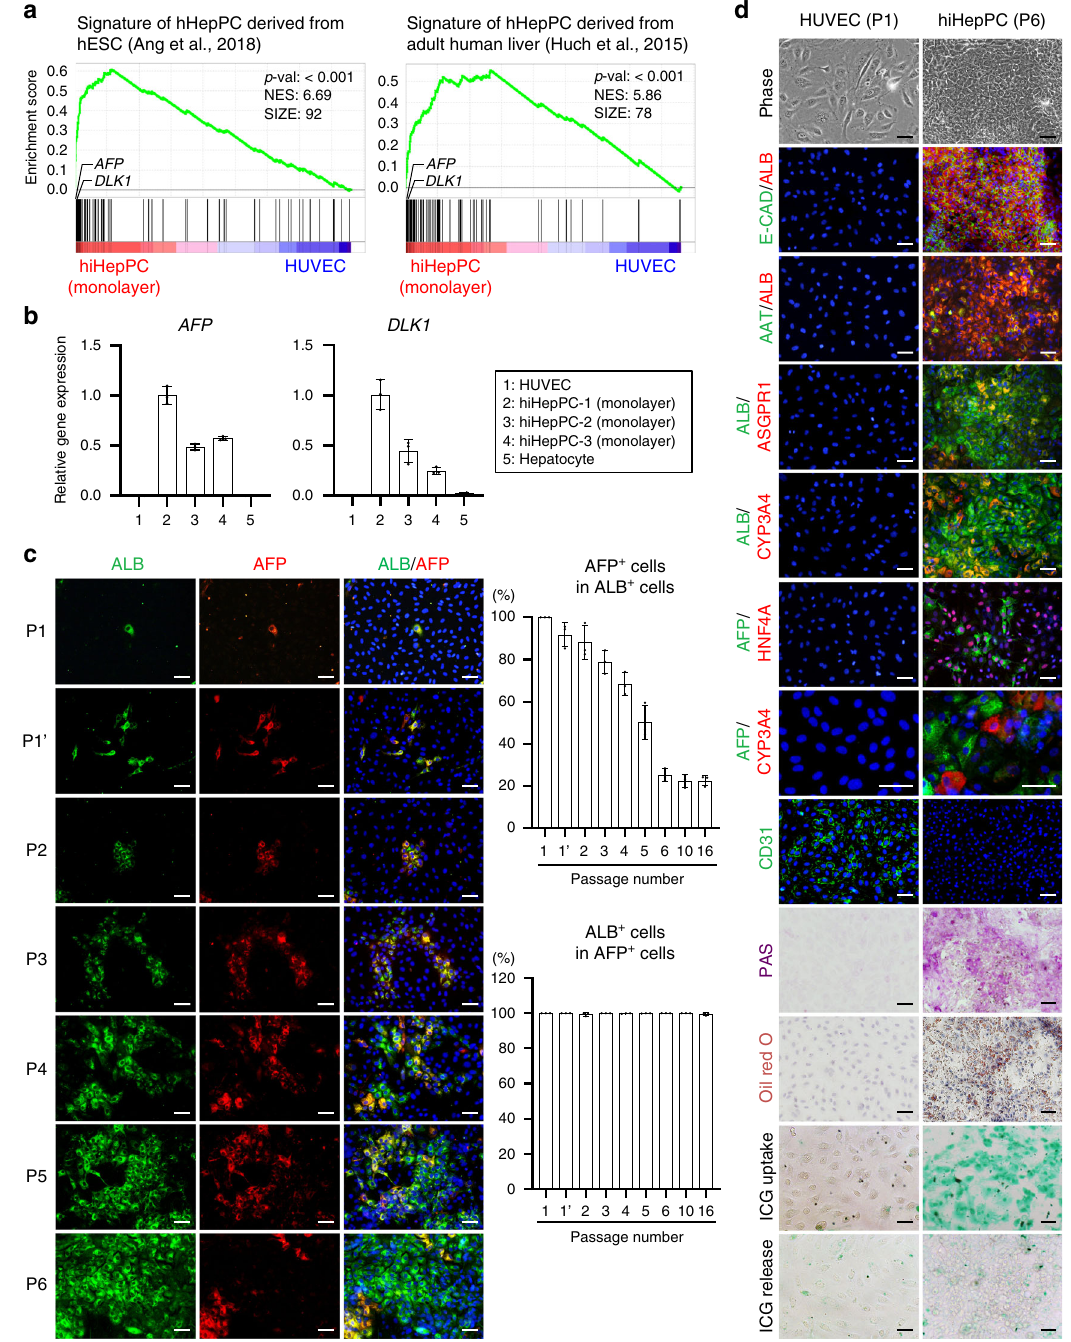
Fig. 2 hiHepPCs are directly induced from HUVECs and differentiate into hepatocytes. a GSEA of CEL-seq2 data for hiHepPC monolayer cultures at passage 8 and HUVECs was performed using the set of top 100 genes speci fi cally upregulated in hHepPCs derived from hESCs 13 or adult human livers 14 . b qPCR analyses of hHepPC marker genes were performed on total RNA obtained from HUVECs, three different hiHepPCs at passage 8 in monolayer culture, and human hepatocytes. All data were normalized with the values for hiHepPC-1 (monolayer), and the fold differences are shown. Data represent the mean ± SD ( n = 3 independent assays). c Co-immuno fl uorescence staining of ALB with AFP was conducted for hiHepPCs induced from HUVECs at the indicated passage numbers (P). P1 and P1 ’ designate days 4 and 7, respectively, after the initial passage of transduced HUVECs. The upper and lower right graphs show the percentages of AFP + cells in ALB + cells and ALB + cells in AFP + cells, respectively, which were observed in individual cultures of hiHepPCs during passaging. Data represent the mean ± SD ( n = 3 independent experiments). d Co-immuno fl uorescence staining of ALB with E-CAD, AAT, ASGPR1, or CYP3A4 and of AFP with HNF4A or CYP3A4 and immuno fl uorescence staining of CD31 were conducted for mock-infected HUVECs at passage (P) 1 and hiHepPC monolayer cultures at P6. Periodic acid – Schiff (PAS) staining and oil red O staining were also conducted for mock-infected HUVECs and hiHepPC monolayer cultures to visualize glycogen stores and lipid synthesis, respectively, in hiHepPC-derived hepatocytes. Additionally, ICG uptake and subsequent release by hiHepPC-derived hepatocytes are shown. DNA was stained with DAPI. Scale bars, 50 µ m. Source data are provided as a Source Data fi